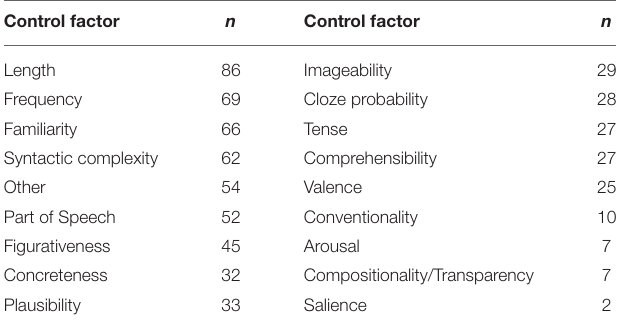
TABLE 2 | Number of studies controlling for each influence factor. Total studies: n =